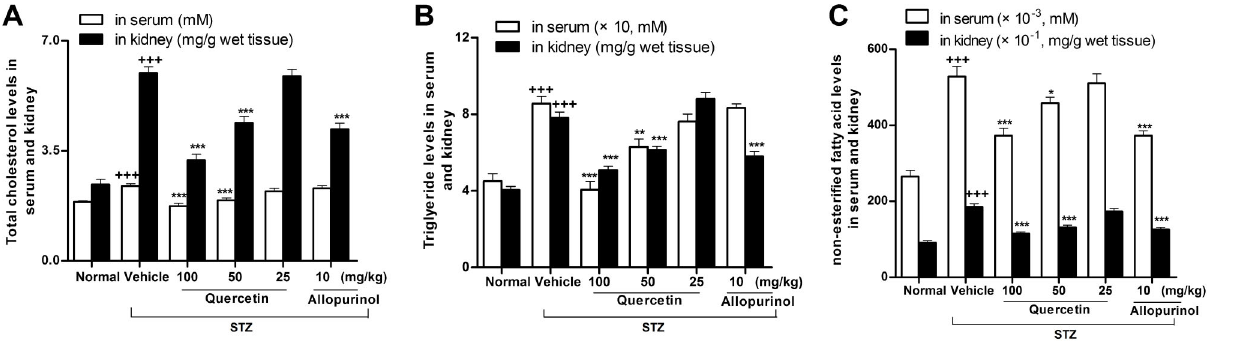
Figure 4. Quercetin and allopurinol reduce lipid levels in streptozotocin (STZ)-treated rats. Biochemical analyses showed serum and kidney cortex levels of TC (A), TG (B) and NEFA (C) at 7 weeks after STZ injection in different groups of rats as indicated. The data are expressed as the